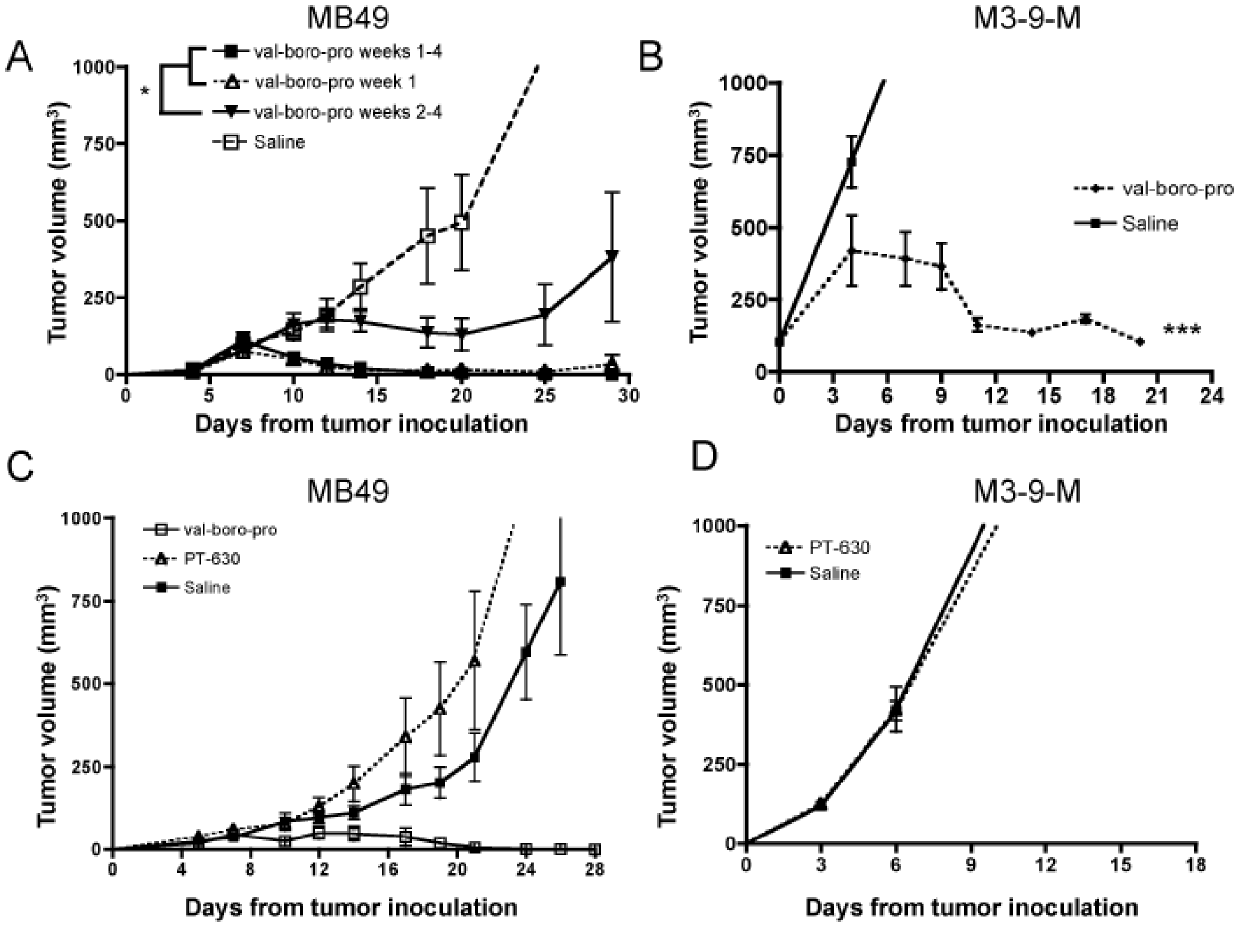
Figure 1. Val-boroPro induces complete regression in multiple tumor models and requires inhibition of intracellular PPCE. (A) C57BL/6 female mice were inoculated with 1 6 10 6 MB49 on day 0. Mice were treated with saline (open squares) or 20 m g Val-boroPro 5 6 /week during weeks 1 through 4 (days 3–28, closed squares), week 1 only (days 3–7, open triangles), or weeks 2 through 4 (days 10–28, inverted solid triangles) (n=6/group). All treatment groups are statistically different than saline (Anova, p , 0.05 for late treament vs saline and p , 0.01 for early treatment groups vs saline). The days 10–28 group is also statistically different than both early treatment groups (p , 0.05). (B) C57BL/6 mice were inoculated with 1 6 10 6 M3-9-M on day 0 and treated with 20 ug Val-boroPro (dashed line) or saline (solid line) for four weeks (n=5/group). Tumor volumes are statistically different between the Val-boroPro and saline groups at p , 0.001 for all times beyond day 10. (C) Mice were inoculated with MB49 as in Figure 1A and treated with 20 ug Val-boroPro (open squares), 20 ug PT-630 (open triangles), or saline (closed squares) (n=5/group). (D) Mice were inoculated with M3-9-M as in Figure 1B and treated with PT-630 (open triangles) or saline closed squares) (n=5/group). Mean tumor volumes show that PT-630 treatment was no different from saline. Figures 1A–D are representative of 3 or more